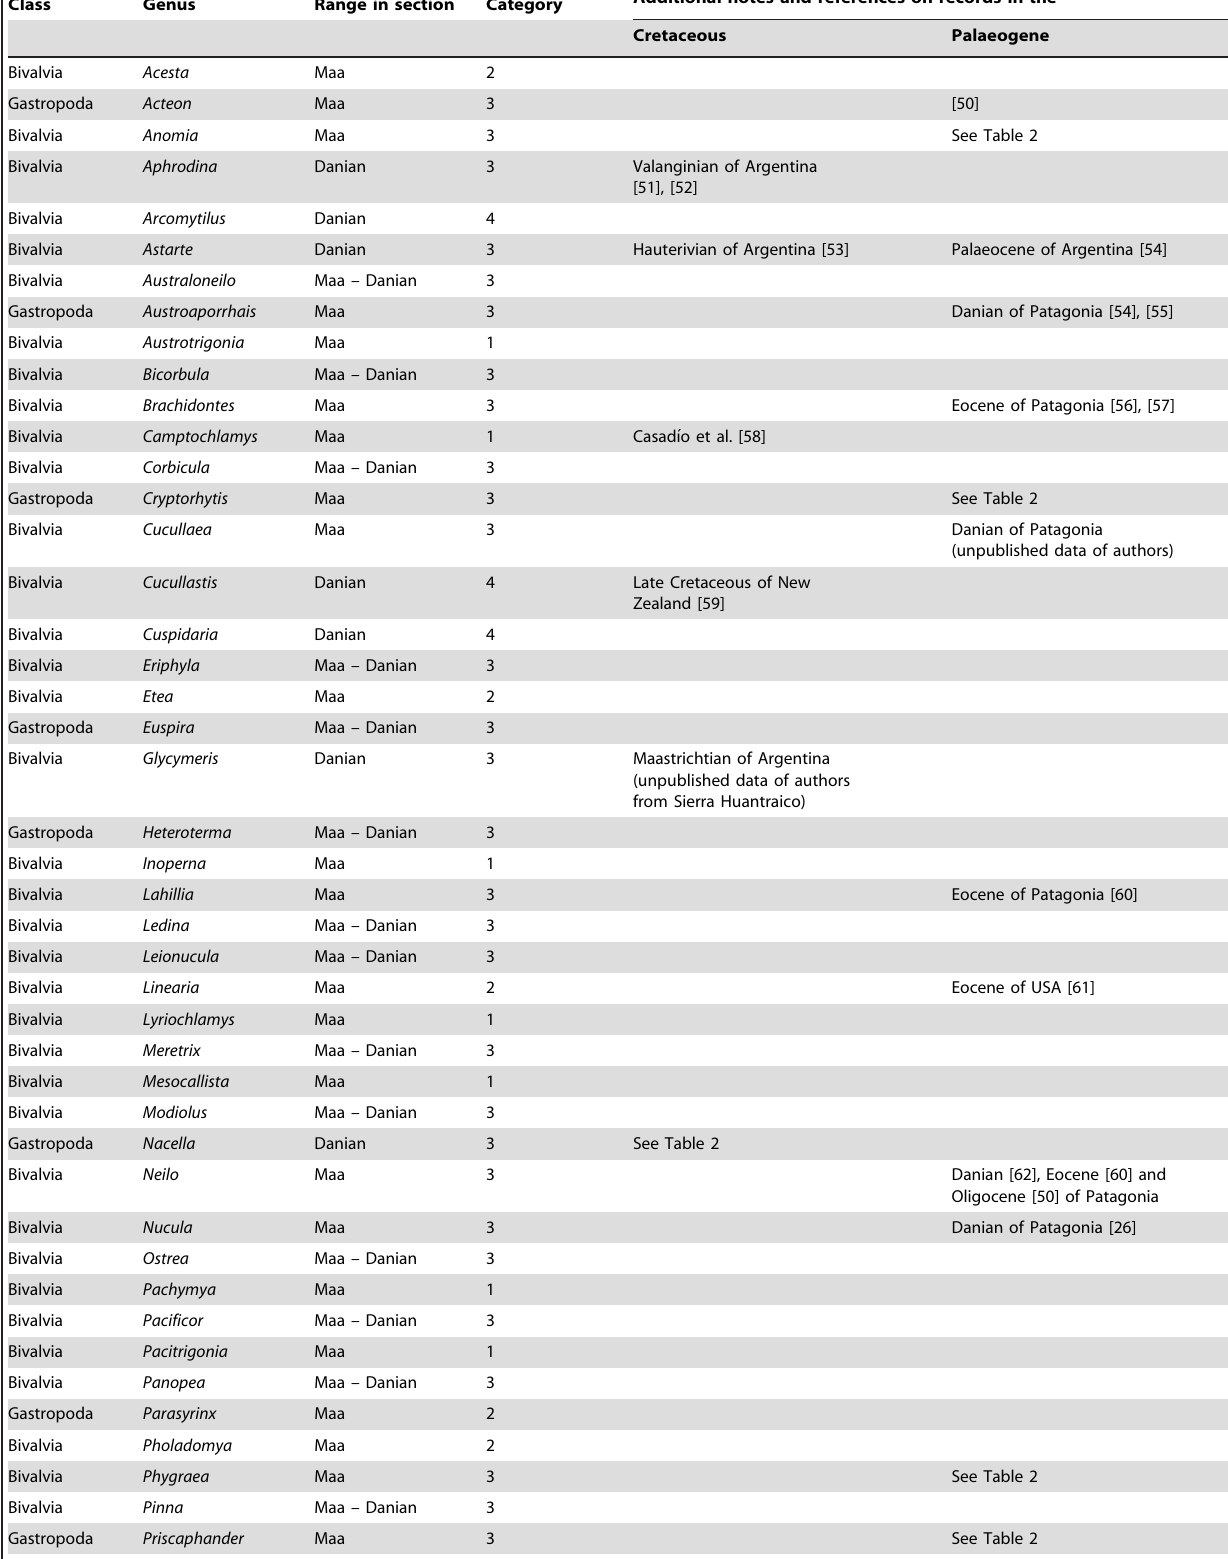
Table 1. Categorisation of molluscs at San